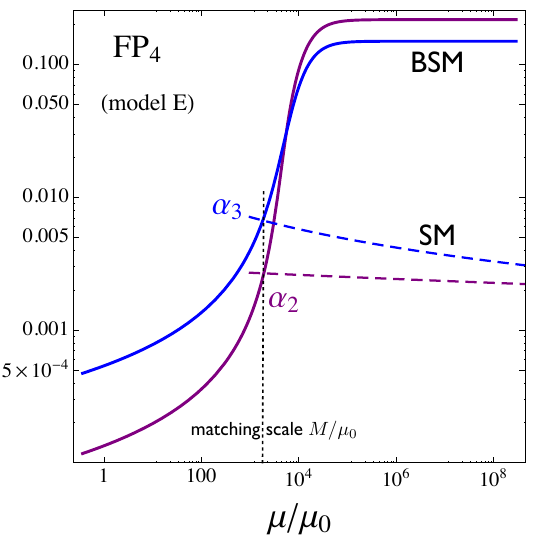
Figure 13 . The matching procedure at FP 4 for the benchmark model E with parameters (4.22). The thick lines show the BSM running along the UV-IR connecting separatrix as a function of the scale (cid:22) 0 , which may take any value determined by the free parameter (cid:14)(cid:11) 3 ((cid:3)). The dashed lines show the SM running of couplings from (cid:12)gure 5 provided that (cid:22) 0 = 1 GeV. It is observed that SM and BSM values both coincide at the matching scale M (cid:25) 1 : 6 TeV, see (4.2), indicated by the short-dashed vertical